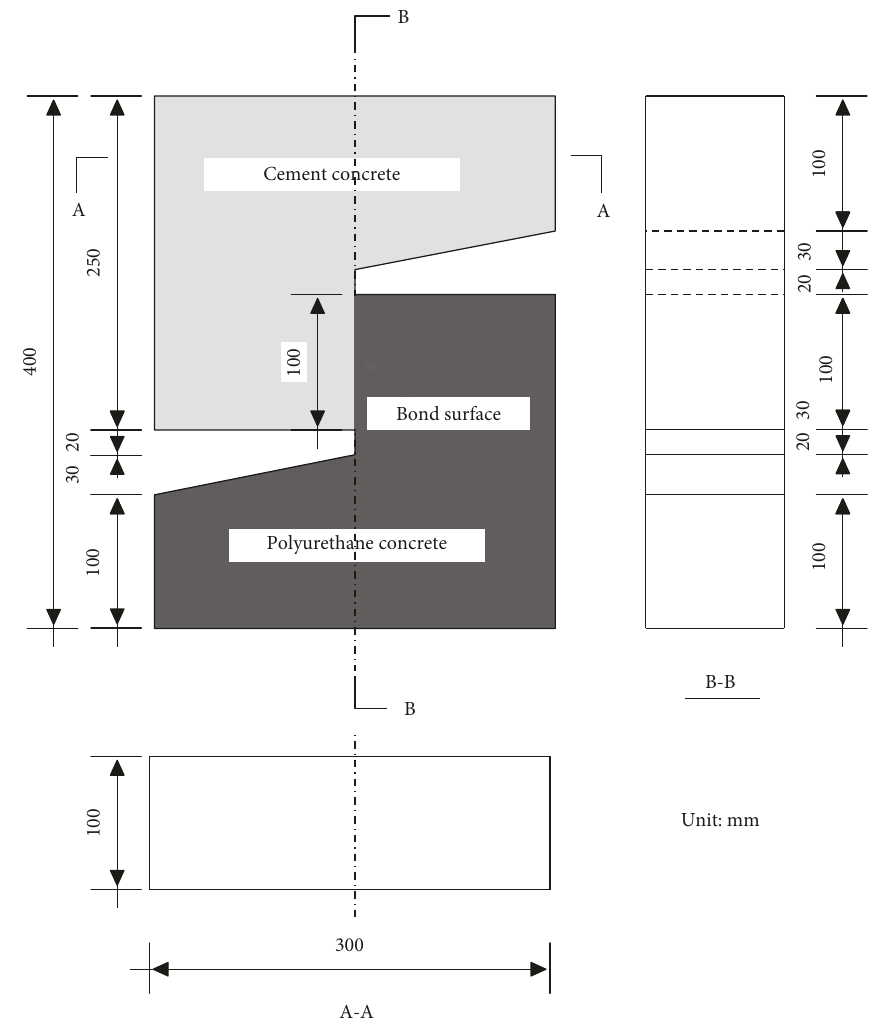
Figure 10: Dimensions of direct shear bond strength